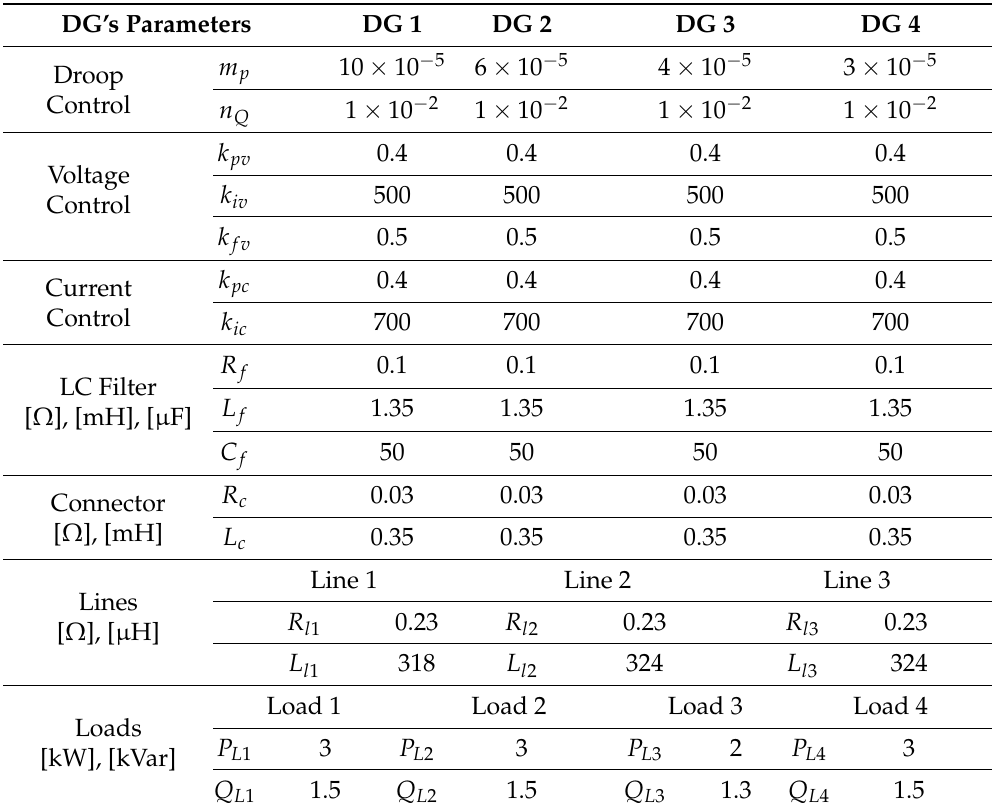
Table 1. Parameters Values for the Microgrid Test System